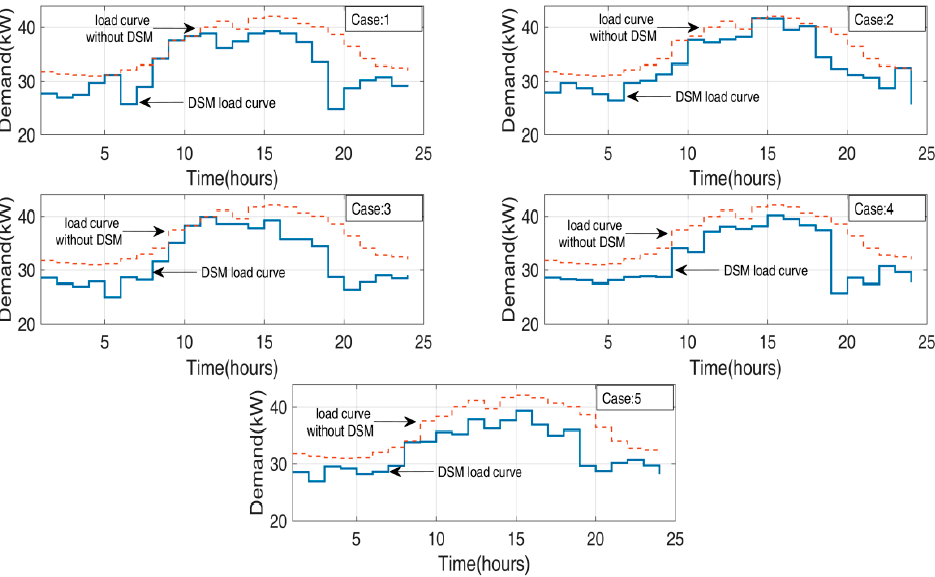
Figure 13. Load curves obtained for cases 1–5 with DSM. Table 3. Load curve data for DSM cases